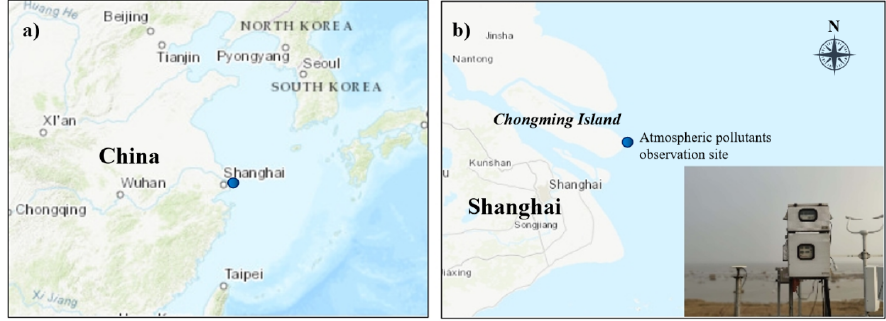
Figure 1. Monitoring site of atmospheric mercury at Chongming Island ( a ), Shanghai ( b )